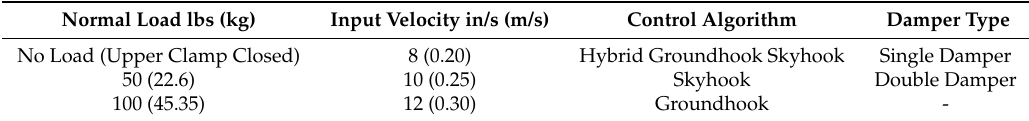
Table 7. Different operating conditions for Damper